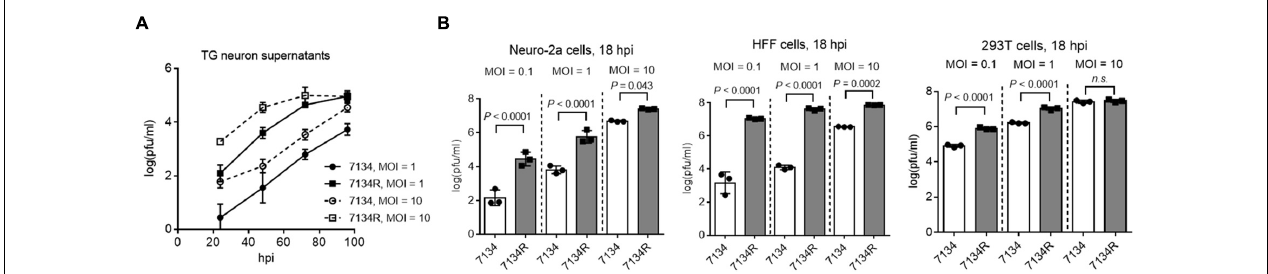
FIGURE 1 | ICP0 is important for HSV-1 replication in neuronal cells. (A) Primary mouse TG neurons were infected with 7134 or 7134R at an MOI of 1 or 10 as indicated. At the indicated times post-infection, supernatants were collected for virus titration. (B) Neuro-2a (left), HFF (middle), and 293T (right) cells were infected with 7134 or 7134R at the indicated MOI and harvested at 18 hpi for virus titration. Data were analyzed by one-way ANOVA with Sidak’s multiple comparisons tests and are presented as mean values ± standard deviations (SD).